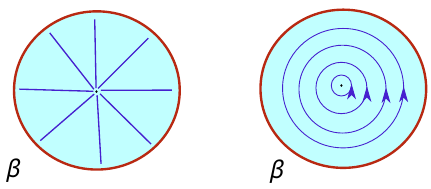
Figure 14 . Cauchy surfaces (left) and time (cid:13)ow (right) on a Euclidean hyperbolic